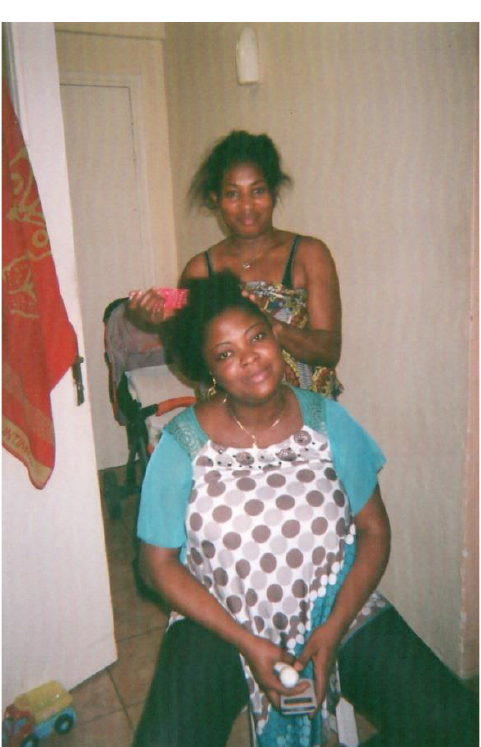
Figure 2: Doing each other’s hair at home (photo: visual diaries project)